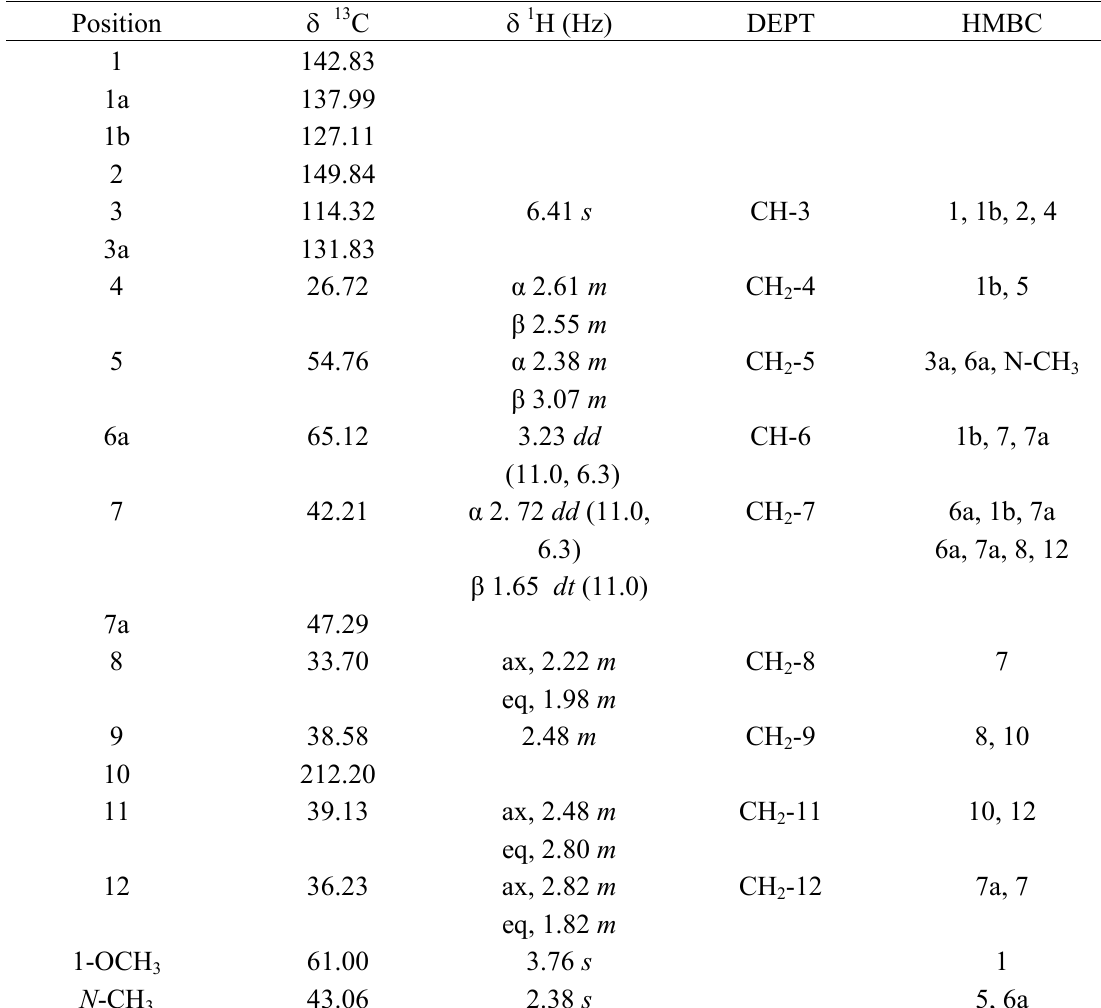
Table 2 . 1 H-NMR (400 MHz) and 13 C-NMR (100 MHz) spectral data of compounds 2 in CDCl plus two drops of CD OD ( δ in ppm, J in 3 3